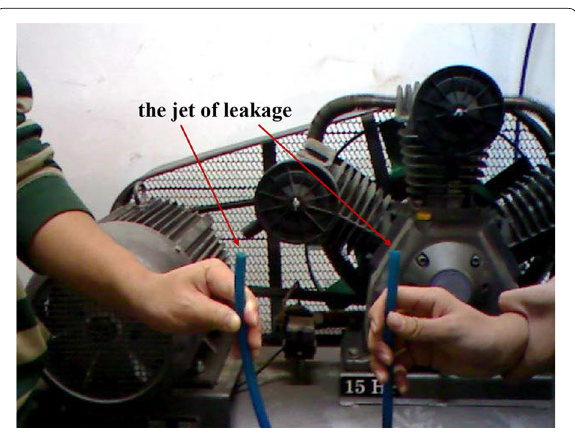
Figure 11 Gas leakage experiment